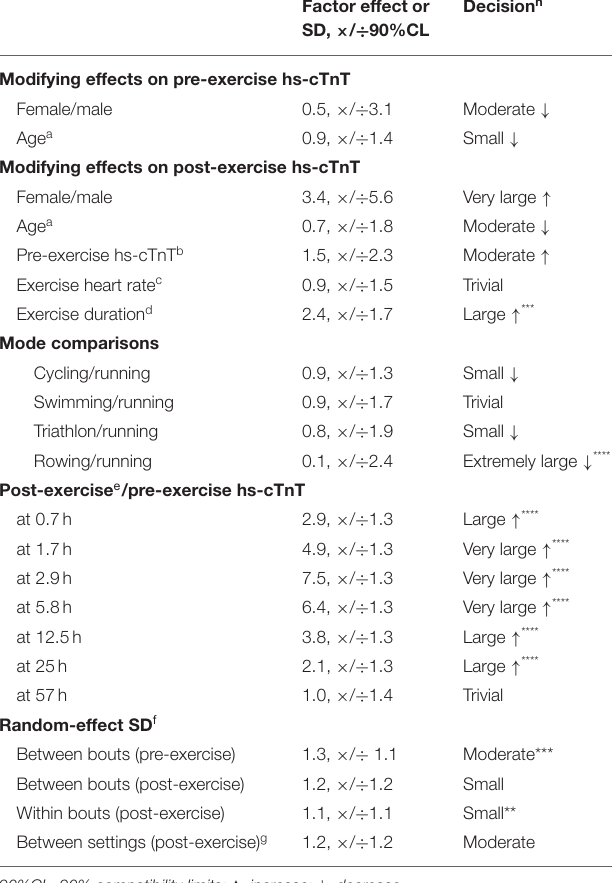
TABLE 2 | Meta-analyzed modifying effects on pre- and post-exercise serum concentration of high-sensitivity cardiac troponin T (hs-cTnT), and the random effects expressed as standard deviations